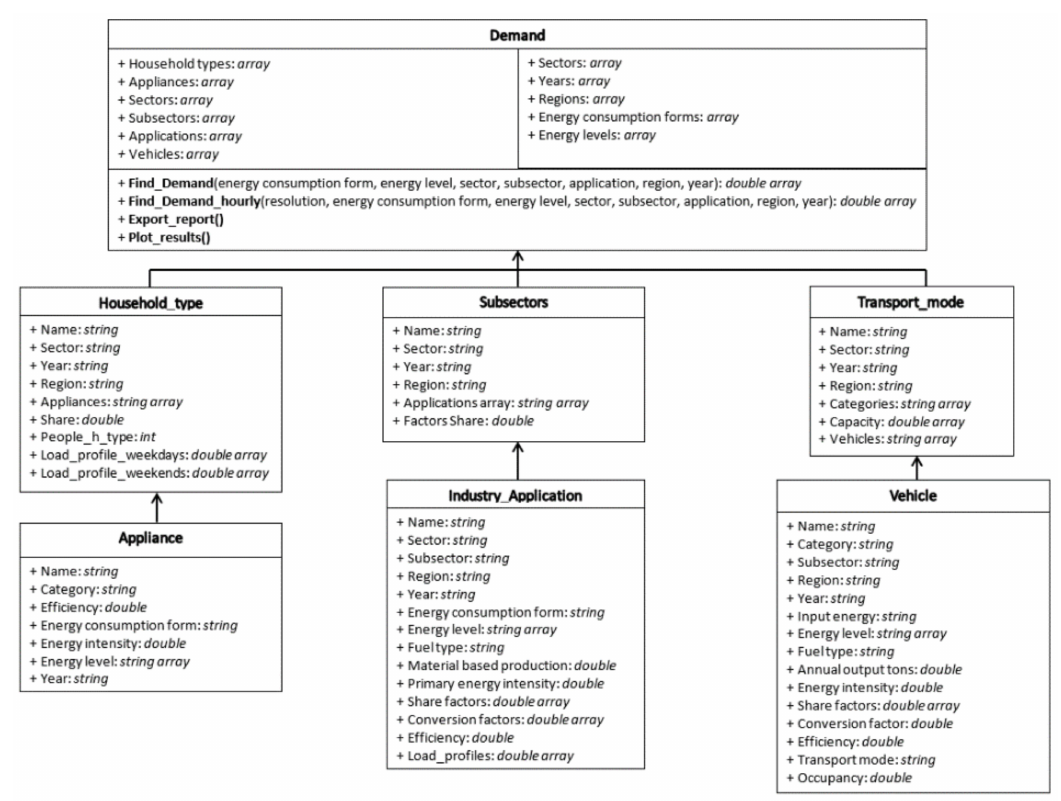
Figure 5. A Unified Modelling Language (UML) diagram of the demand module in MATLAB, showing its classes, attributes, methods, and